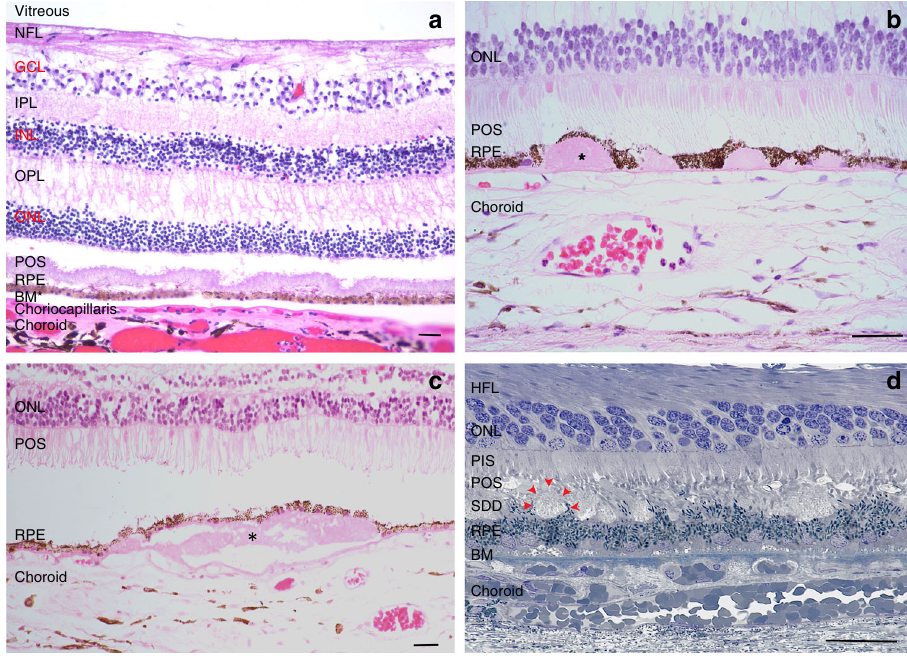
Fig. 2 Histological cross-section of a human macula. a Normal macula. b Hard drusen (*) within Bruch ’ s membrane. c A soft druse (*) within Bruch ’ s membrane. ( b and c are courtesy of Philip Luthert, MBBS, UCL Institute of Ophthalmology.) d Subretinal drusenoid deposits (SDDs) between shortened photoreceptor outer segments and the RPE. Arrows highlight one of several SDDs (Courtesy of Christine Curcio, Ph.D., University of Alabama Birmingham and Project MACULA AMD Histopathology resource (http://projectmacula.cis.uab.edu/). HFL Henle fi ber layer, NFL nerve fi ber layer, GCL ganglion cell layer, IPL inner plexiform layer, INL inner nuclear layer, OPL outer plexiform layer, ONL outer nuclear layer, POS photoreceptor outer segment, RPE retinal pigment epithelium, BM Bruch ’ s membrane. Bar = 25 μ